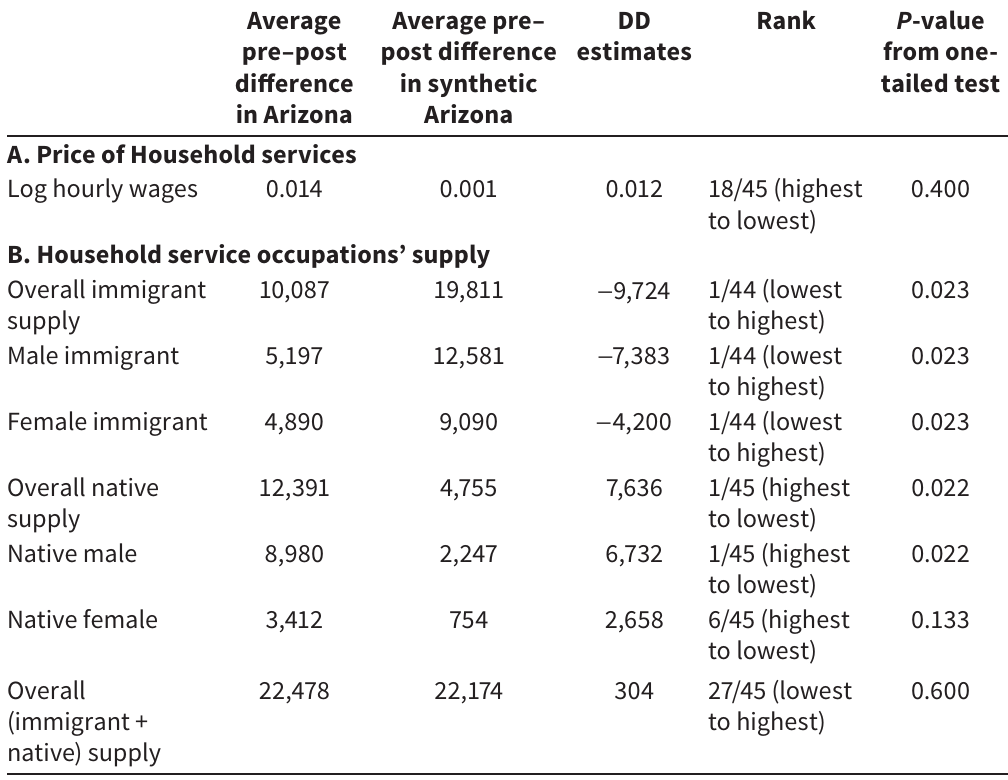
LAWA and household service occupations’ wages/supply Average Average pre– DD Rank P -value pre–post post difference estimates from one- difference in synthetic tailed test in Arizona Arizona